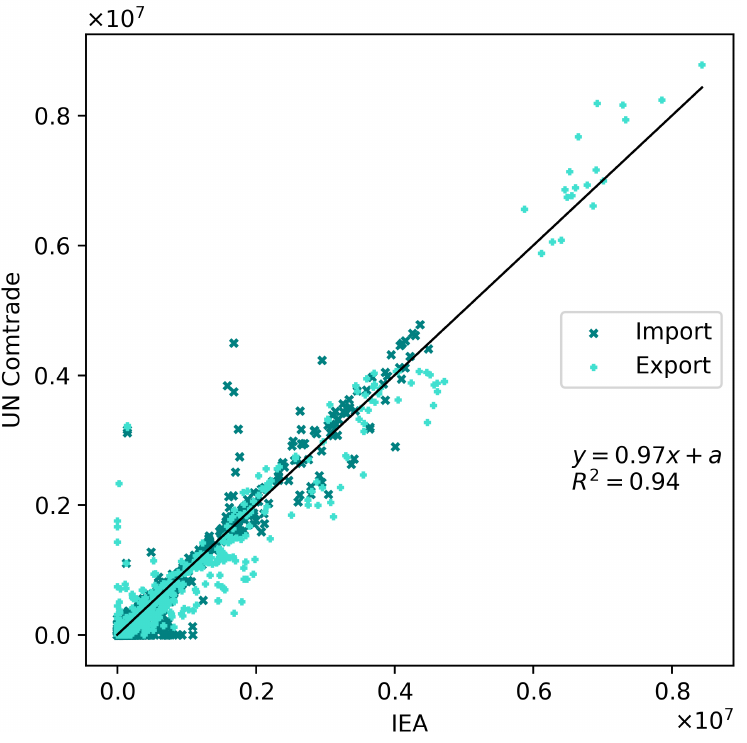
Figure 1. Comparison of the IEA and UNCT datasets for natural gas data.